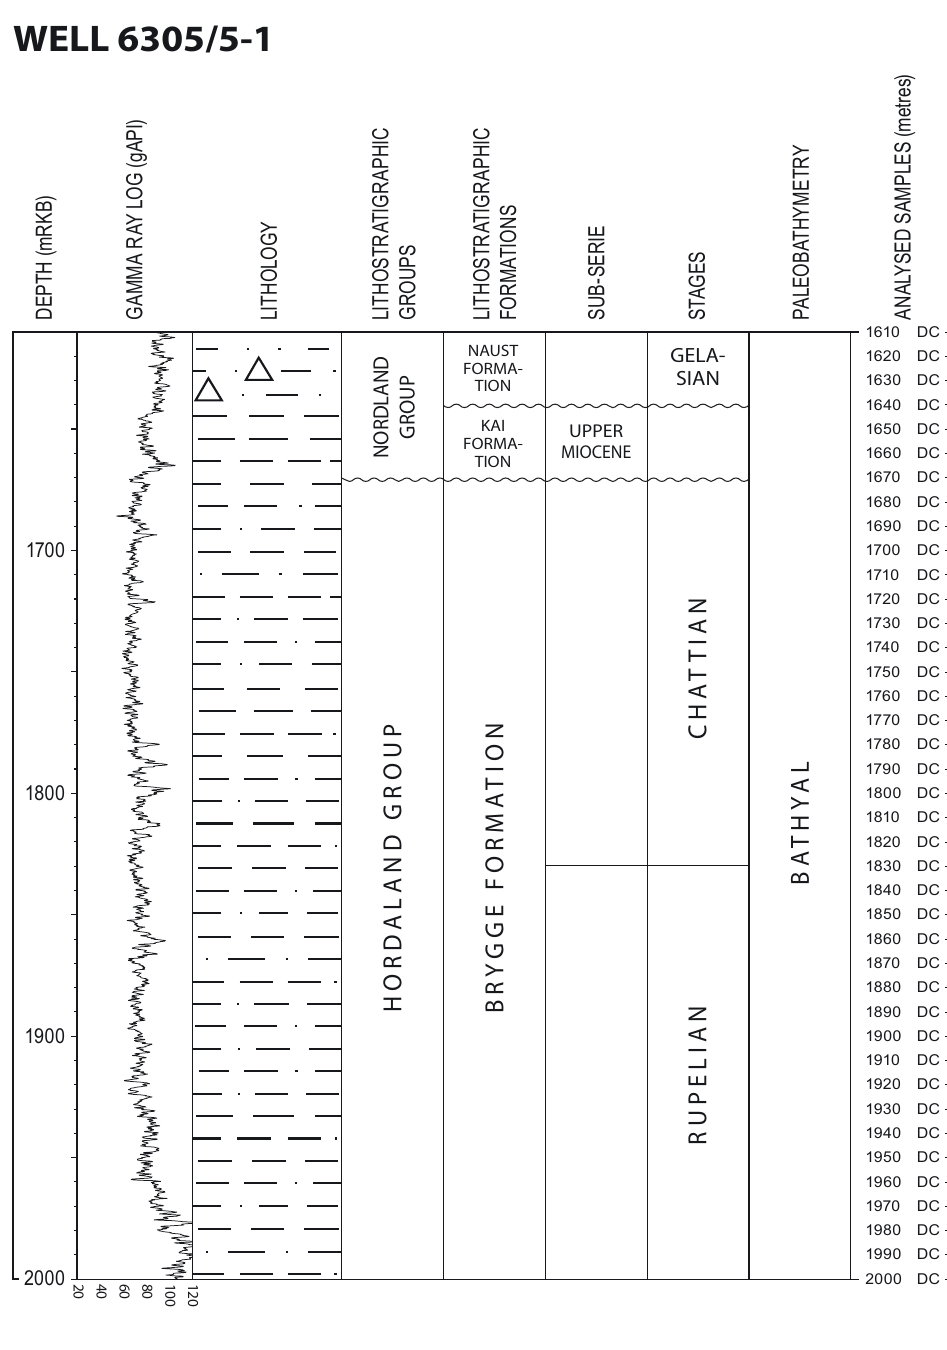
Figure 16. Well summary figure including gamma-ray log, lithology, lithostratigraphic units, sub-series, stages, paleo- bathymetry and analysed samples for the investigated sequence in well 6305/5–1 (Rupelian to Gelasian; modified after Eidvin et al.,